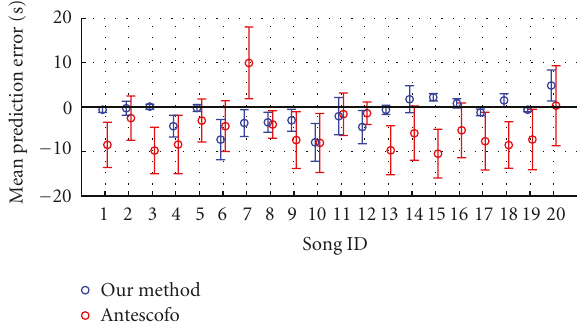
Figure 5: Mean prediction errors in our method and Antescofo: the number of particles N is 1500, the width of the tempo window θ is 15 (bpm).